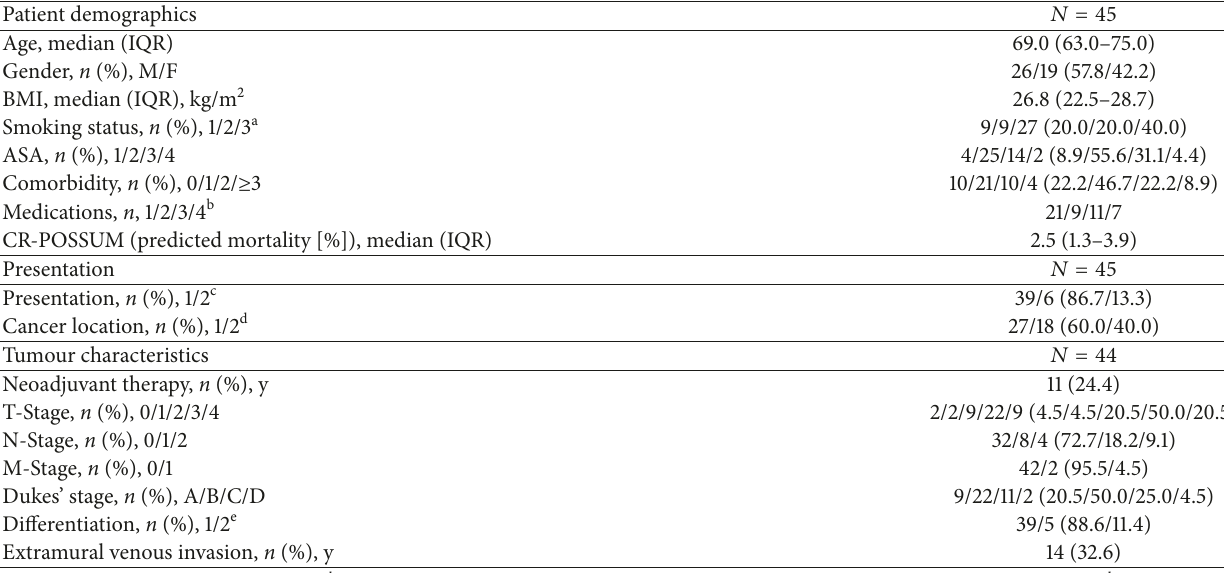
Table 1: Population characteristics.